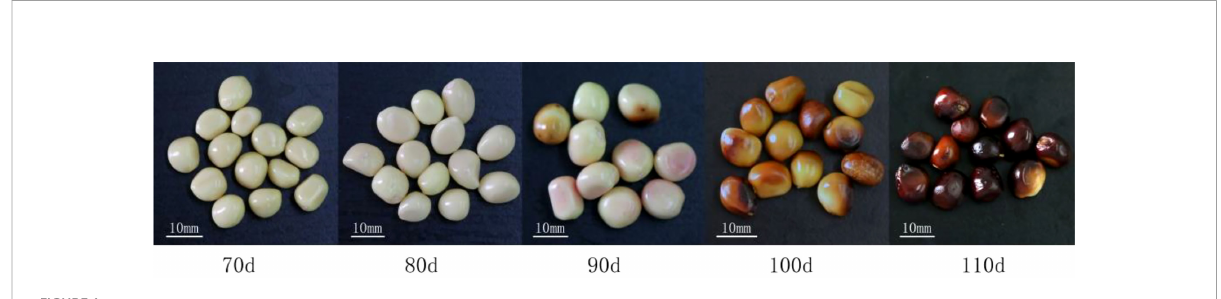
FIGURE 1 The seeds of “ Fengdanbai ” at different developmental stages after fl